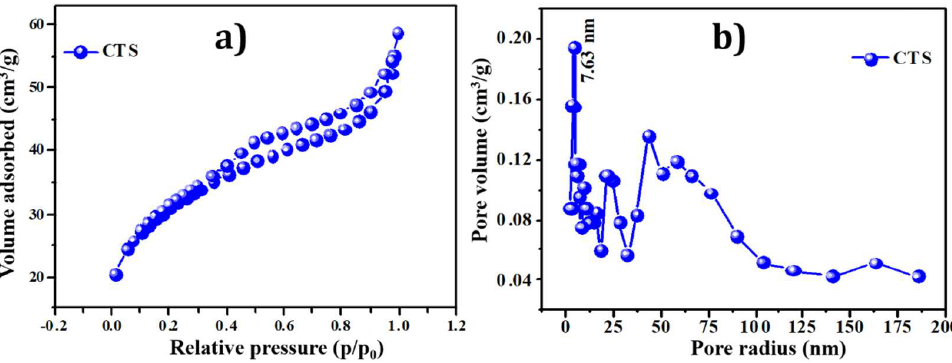
Figure 5. ( a ) N2 adsorption-desorption isotherm curve and ( b ) pore size distribution of CTS NPs.